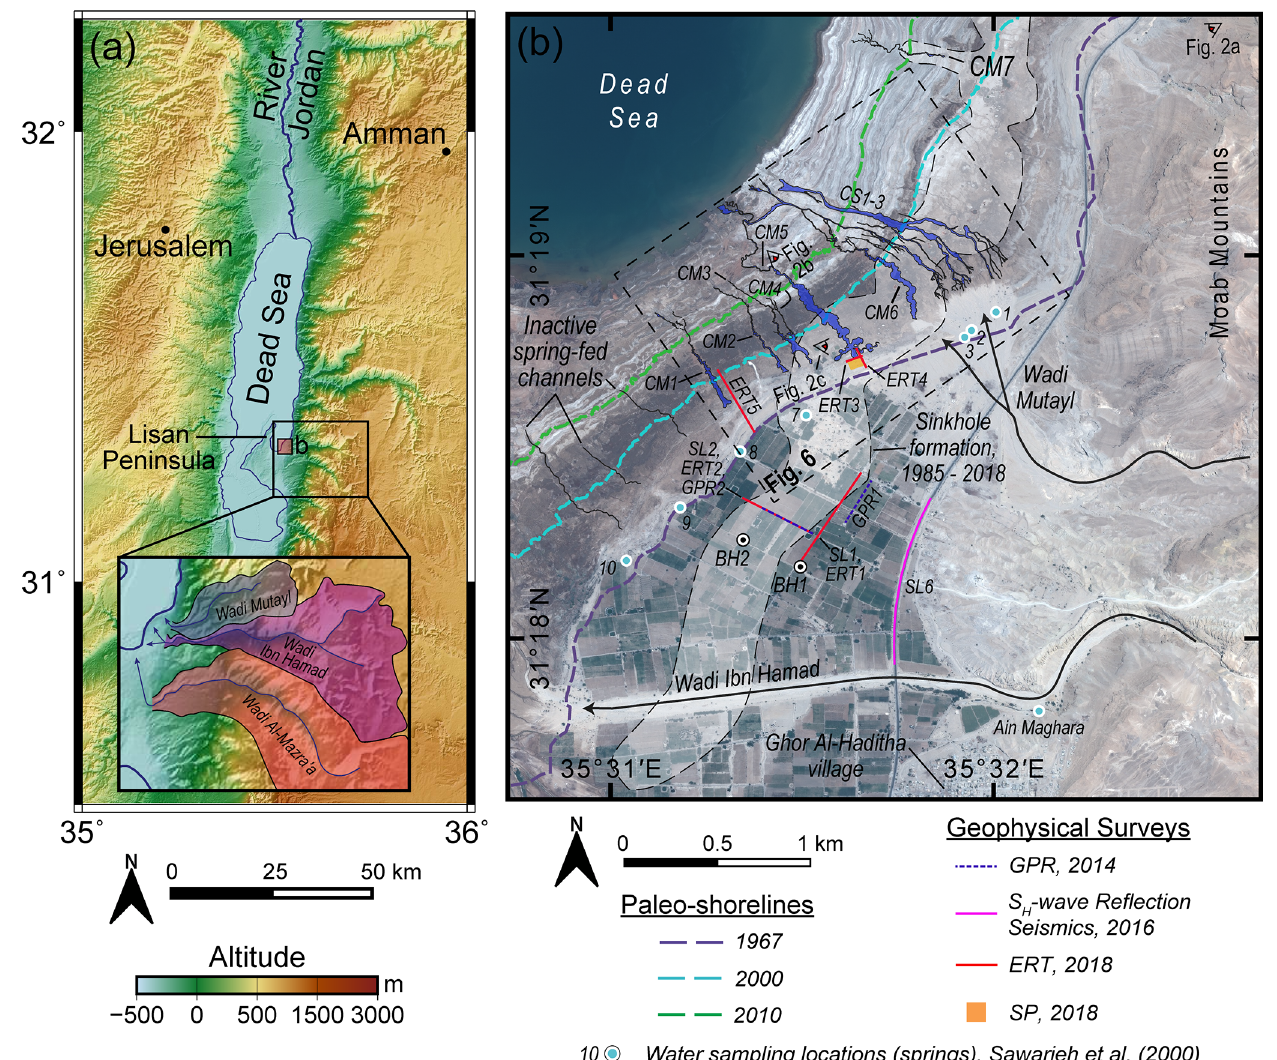
Figure 1. Overview of the Ghor Al-Haditha field site. (a) Topographic map showing the location of the study area and field site on the eastern Dead Sea shore, Jordan. Elevation data are derived from the Shuttle Radar Topography Mission (Farr et al., 2007). The inset shows the catchments of the three major wadis flowing to the Dead Sea shoreline in the study area: Wadi Mutayl, Wadi Ibn Hamad, and Wadi Al-Mazra’a. (b) Pleiades 2018 satellite image of the study area showing the studied groundwater-fed stream channels (blue) mapped from satellite imagery and close-range photogrammetric surveys. Label CM- refers to meandering-type channels, and CS- refers to straight or braided channels. Geophysical survey lines or areas, as analysed in this work, are marked. Seismic lines SL1 and SL2 refer to S-wave reflection profiles 1 and 2 acquired in 2014 (Polom et al., 2018). The two boreholes of El-Isa et al. (1995) are labelled “BH1” and “BH2”. The area affected by sinkhole formation from 1985 to present is represented by the dashed outline with shaded infill. The numbered blue and white dots represent the approximate locations of groundwater springs sampled during a previous field campaign in the study area in 1999, from Sawarieh et al. (2000), and discussed further in Sect.